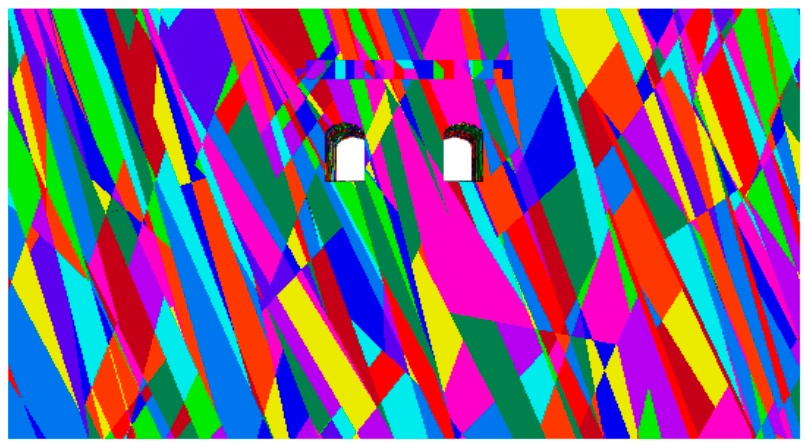
Figure 18. Numerical model of the engineering project.